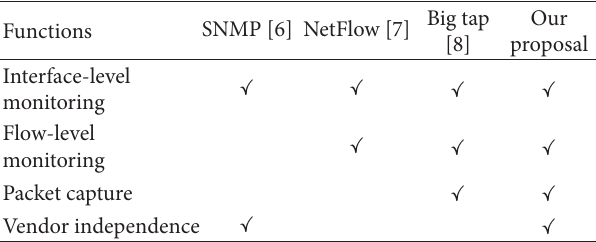
Table 1: Comparison of traditional monitoring systems and our proposed